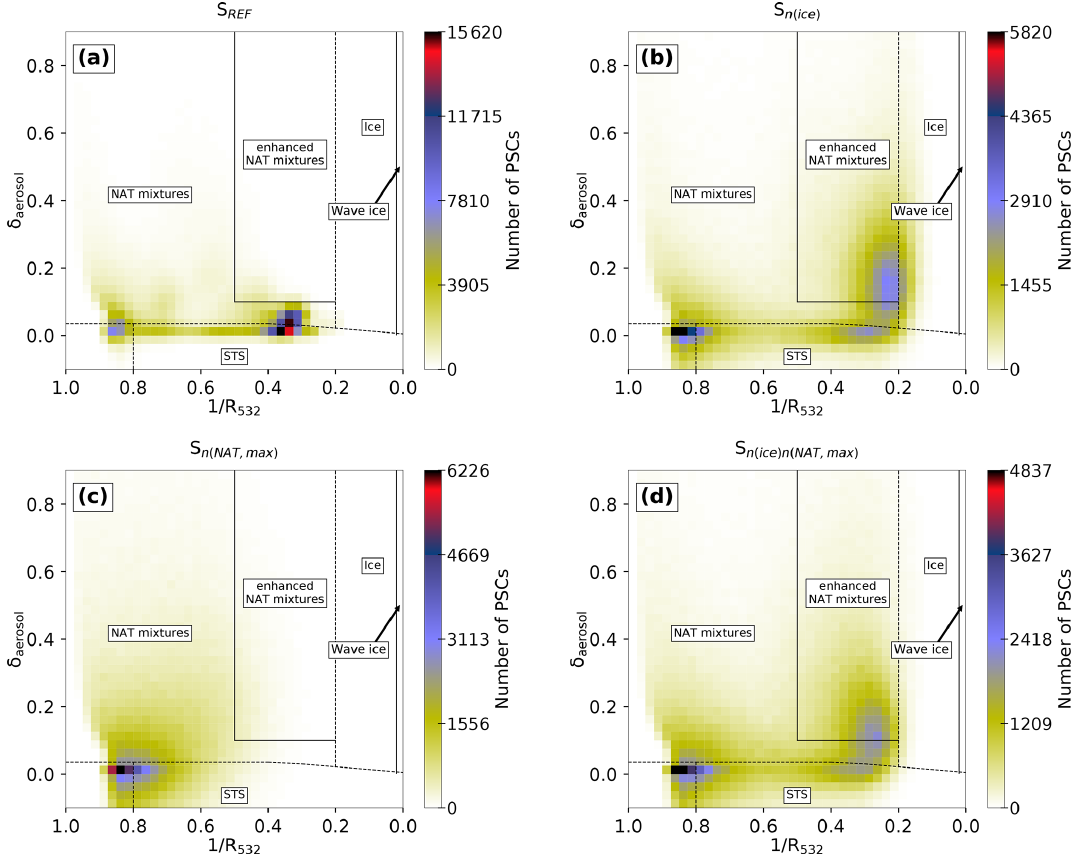
Figure 6. Composite 2D histograms for July 2007, analogous to Fig. 1, for the simulations S REF (a) , S n( ice ) (b) , S n( NAT , max ) (c) and S n( ice ),n( NAT , max ) (d) .